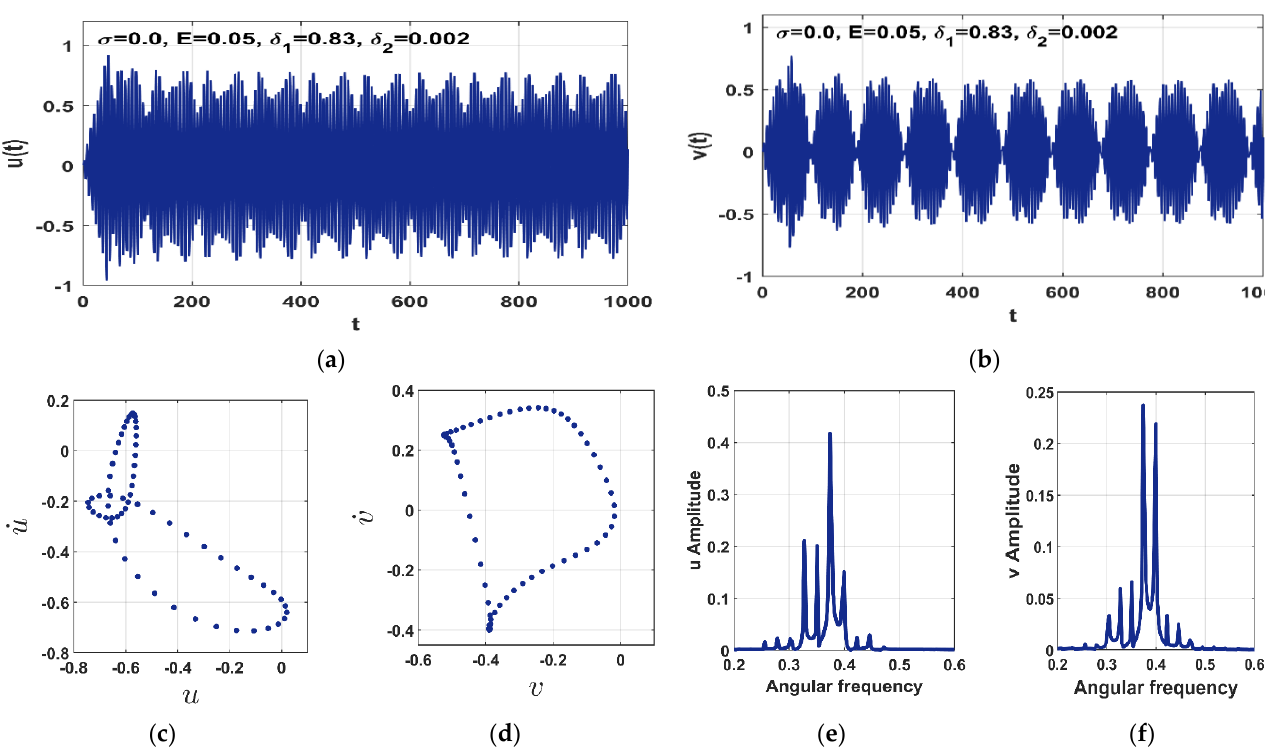
Figure 9. Quasi-periodic time-response, Poincaré-map, and frequency-spectrum of the controlled Jeffcott-rotor according to Figure 7 (i.e., at σ = 0, δ 1 = 0.83, δ 2 = 0.002) when E = 0.05: ( a , b ) the normalized temporal oscillations u ( t ) and v ( t ) in X and Y direction, ( c , d ) the corresponding Poincaré-map, ( e , f ) the corresponding frequency-spectrum.